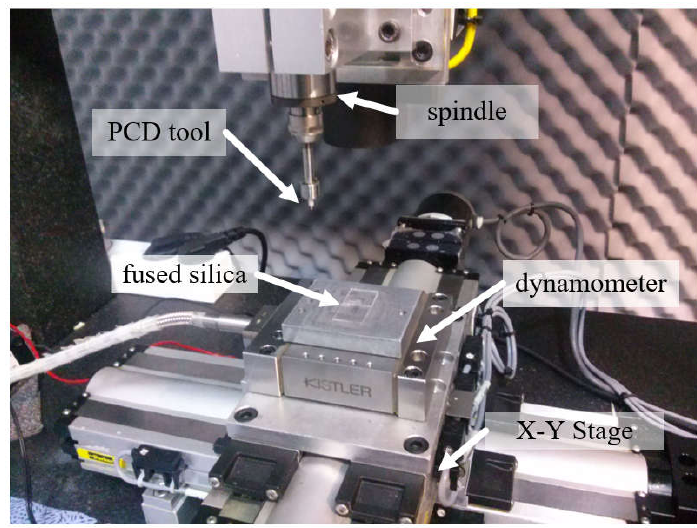
Figure 1. The microgrinding system. Table 1. The physical properties of the fused silica.